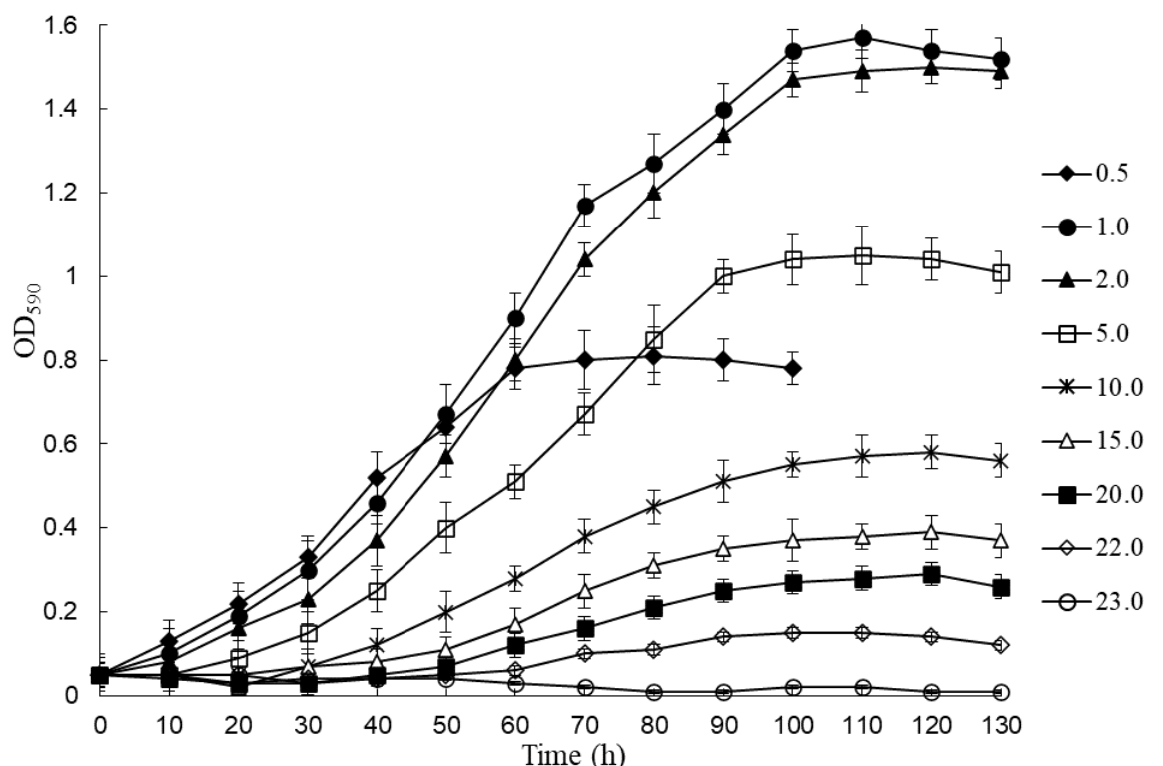
Figure 2. Growth dynamics of Brevibacterium epidermidis BS3 in a mineral medium at different concentrations of caprolactam (g/L) as a sole carbon and energy source. Each value is a mean of three replicates with error bars indicating the standard deviation from the mean. Table 2. Growth values of Brevibacterium epidermidis BS3 vs. caprolactam concentrations in a mineral medium.